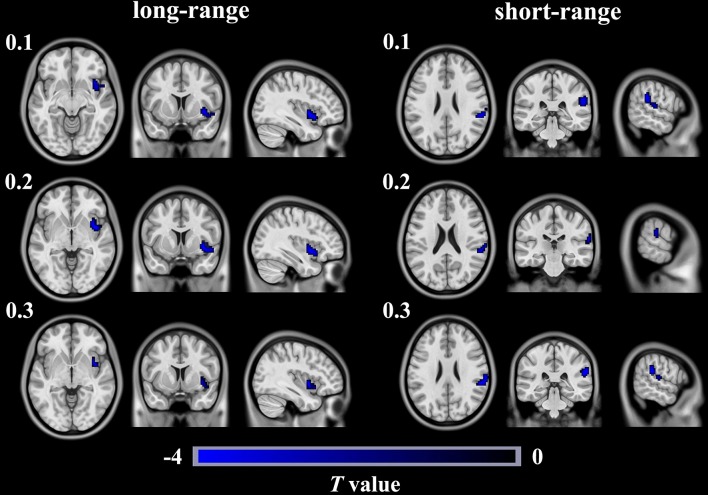
Brain regions show significant differences in long- and short- rangersFCS between T2DM patients and healthy controls in different thresholds of 0.1, 0.2, and 0.3. The color regions represent weaker long- or short- range rsFCS inpatients with T2DM than in healthy controls. The color bar indicates the T-value from two-sample t-tests. rsFCS, resting statefunctional connectivity strength.